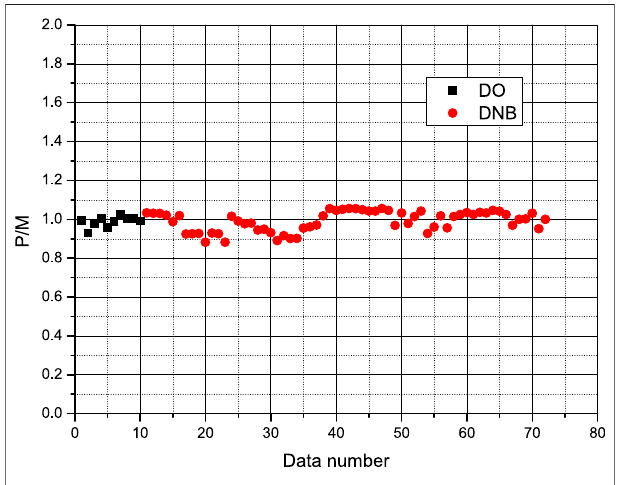
FIGURE 9 | Distribution of P/M in TEST 8.